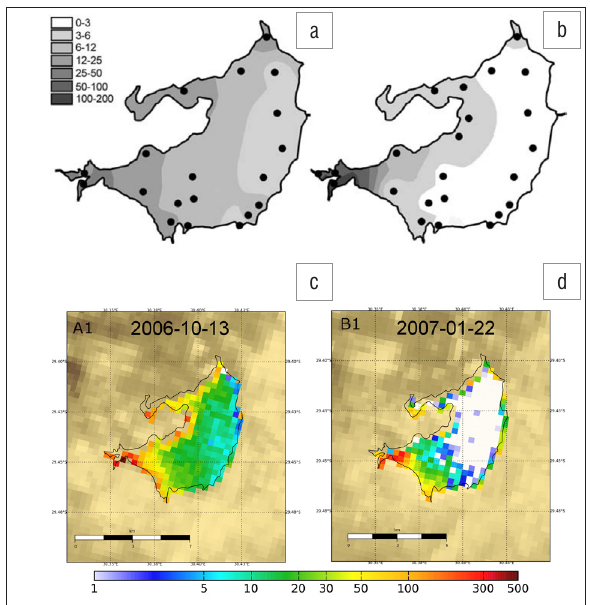
Figure 2: Comparison between time series of satellite-derived chl- a and that measured in situ by the National Eutrophication Monitoring Programme for six reservoirs. Note that the exact position of in-situ sampling was not recorded. GPS coordinates for MERIS pixel extractions (top to bottom): 30.38E 29.45S; 30.19E 29.50S; 27.86E 25.73S; 30.87E 29.69S; 27.81E 25.13S and 28.71E